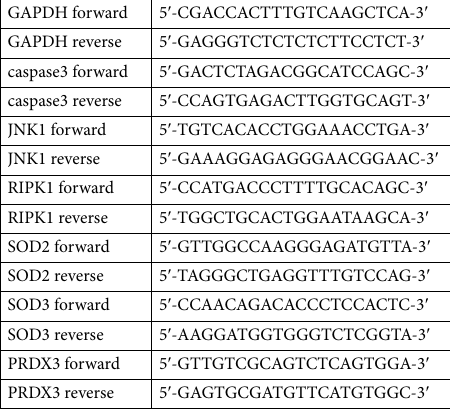
Table 2. Sequence of primers used for real-time